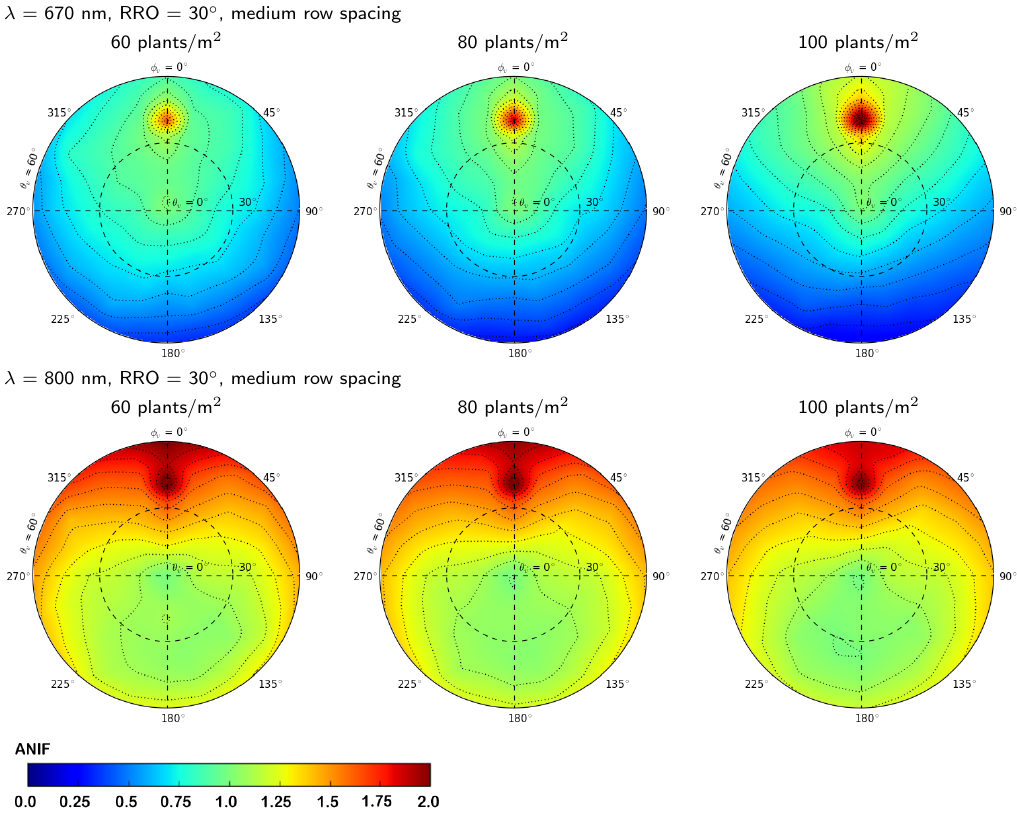
Figure 10. BRDF of winter wheat canopies at early stem elongation at λ = 670 nm and λ = 800 nm with different canopy